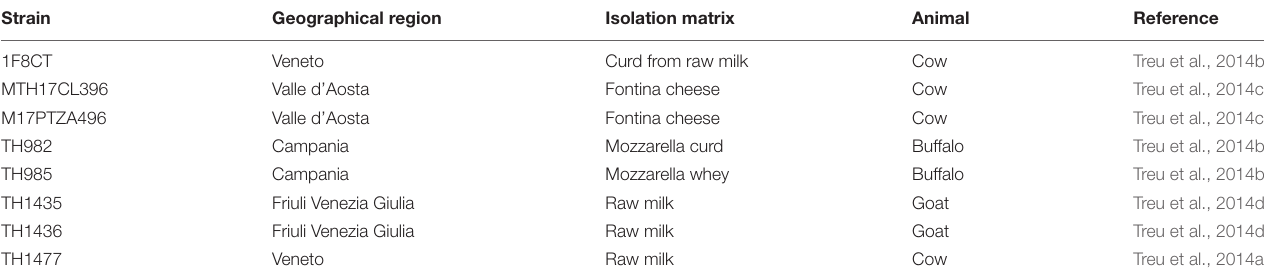
TABLE 1 | Strains of S. thermophilus used in this study.